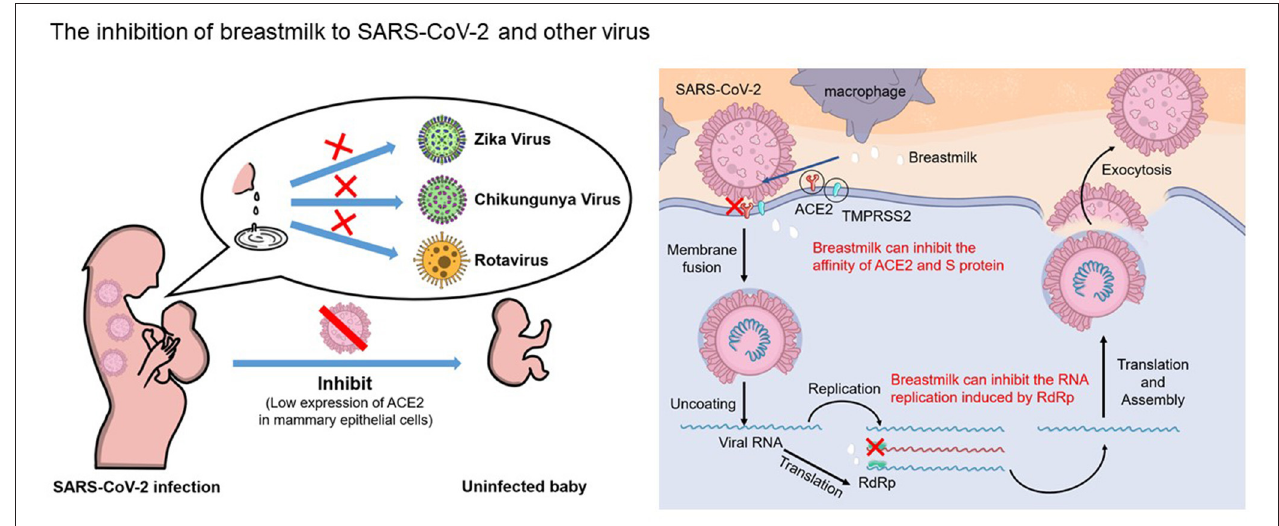
FIGURE 1 | Human breastfeeding should be encouraged for the mothers who are suspected or confirmed with COVID-19. Breast milk provide protection against several pathogens including Zika virus, chikungunya virus and rotavirus; for SARS-CoV-2, breast milk not only block the binding between ACE2 and spike protein, but also potently inhibit RdRp activity of SARS-CoV-2. The antiviral effects of breast milk and low levels of ACE2 expression in the breasts could explain that breast-fed newborns are less likely to be infected with virus from their COVID-19 mothers through breast milk.